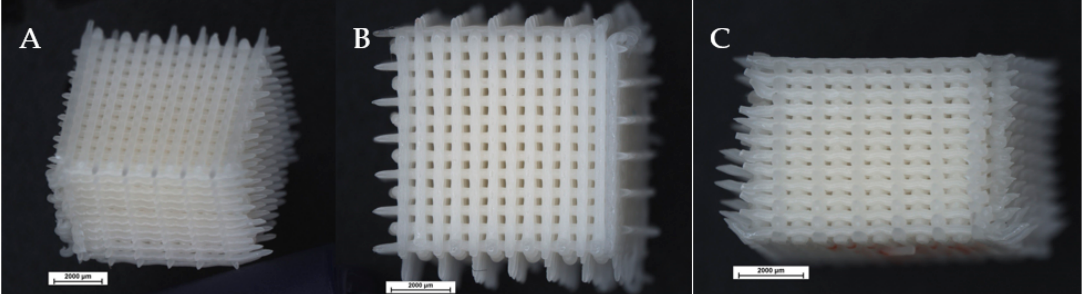
Figure 3. A representative lattice sample from different views; Perspective ( A ), top ( B ) and side ( C ) views.